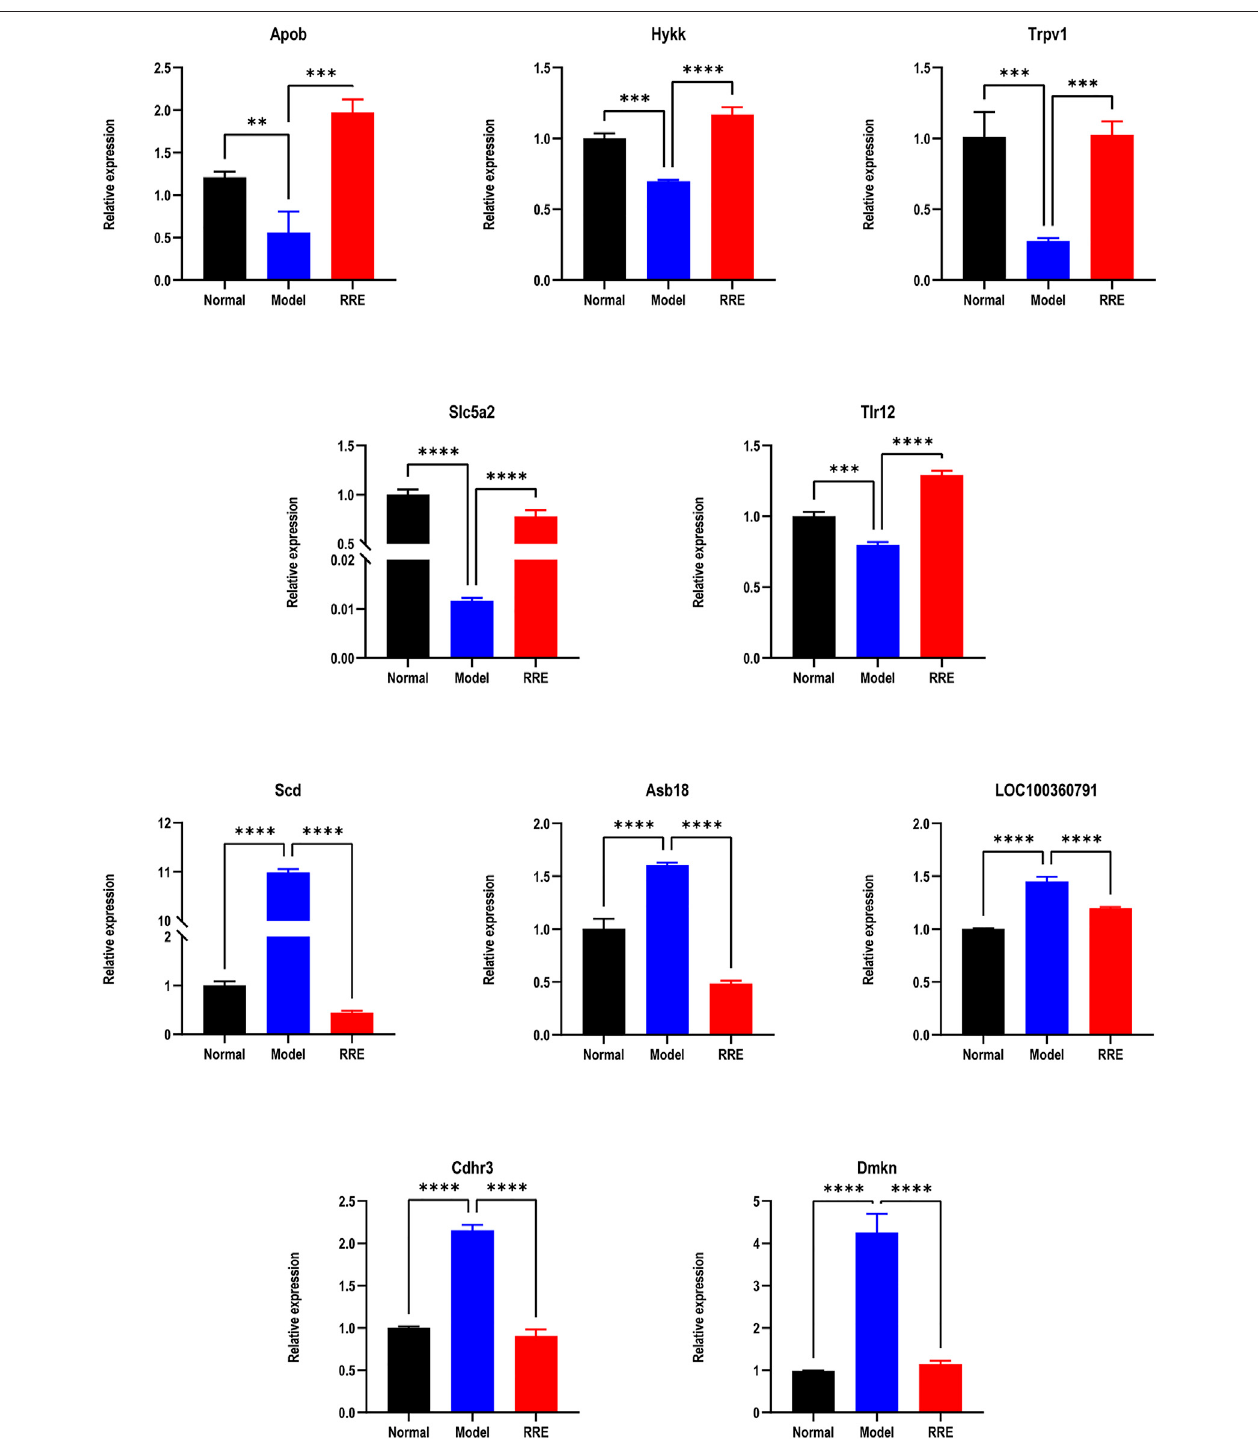
FIGURE 4 | The expression tendency of DEGs by qRT-PCR. Relative expressions of Apob , Hykk , Trpv1 , Slc5a2 , and Tlr12 in the normal vs . model group (down) and the model vs . RRE group (up). Relative expression of SCD1 , Asb18 , LOC100360791 , Cdhr3 , and Dmkn in the normal vs . model group (up) and the model vs. RRE group (down)